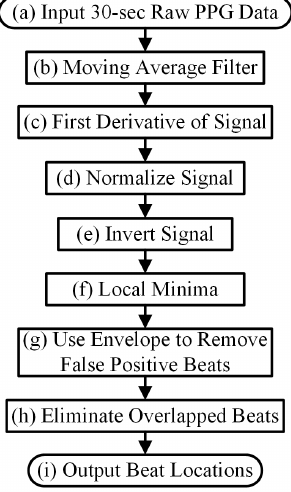
Figure 2. Flowchart of the WEPD